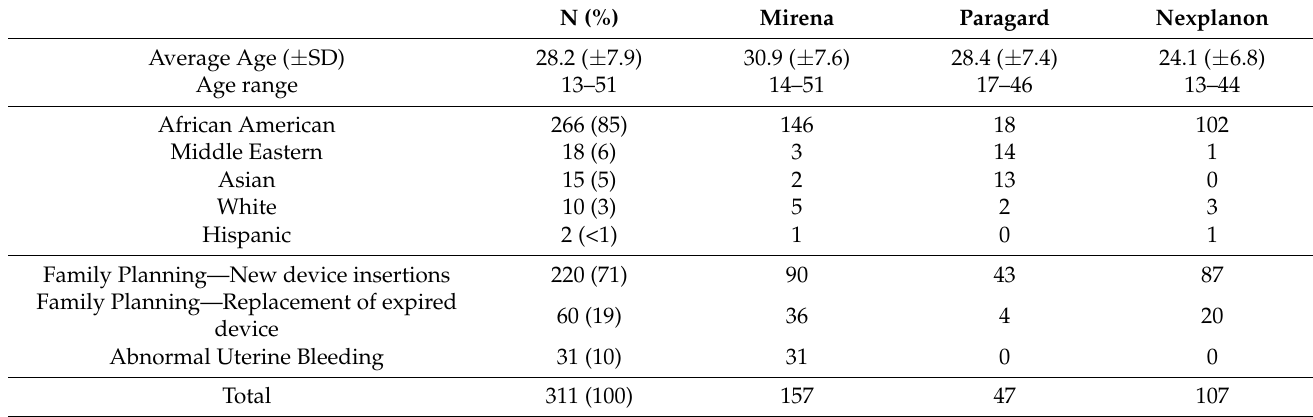
Table 1. Utilization of Long-Acting Reversible Contraception by Age and Ethnicity. N